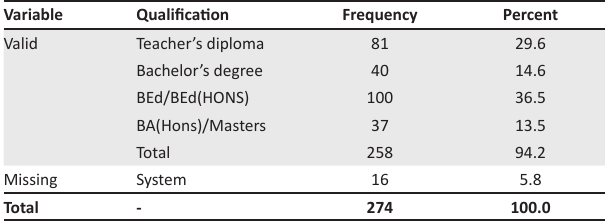
TABLE 5: Frequency distribution of the highest educational qualification.